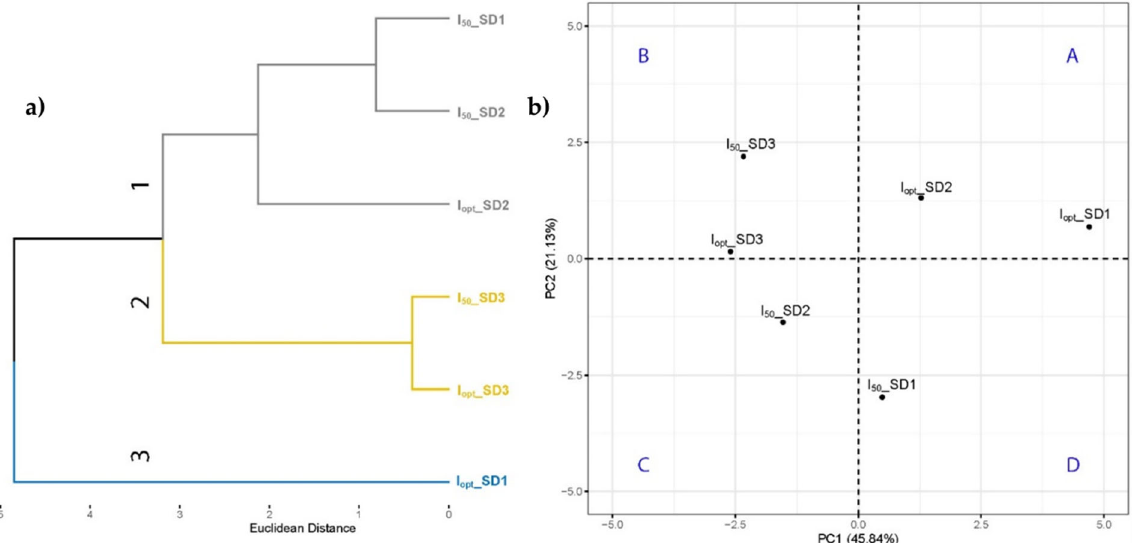
Figure 2. ( a ) Hierarchical cluster analysis (HCA) dendrogram for the monoterpenes compositions of the essential oils extracted from all cannabis accessions. Each joining (fusion) of two clusters is represented on the graph by splitting a horizontal line into two horizontal lines. The horizontal position of the split, shown by the short vertical bar, gives the distance (dissimilarity) between the two clusters. The outlier, Iopt_SD1, was fused in rather arbitrarily at a much higher distance. Two major coupled treatment groups are identified by this analysis and their numbers are presented above the differentiating node. ( b ) Principal component analysis (PCA) score plot for the monoterpenes compositions of the essential oils extracted from all the samples.